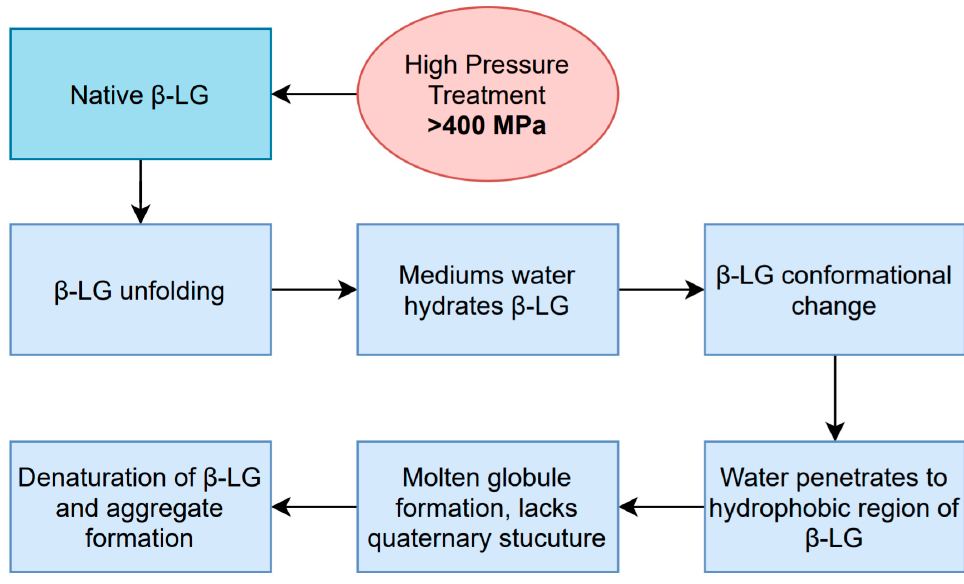
Figure 6. β -LG denaturation by HPP. (Adapted from [47]).